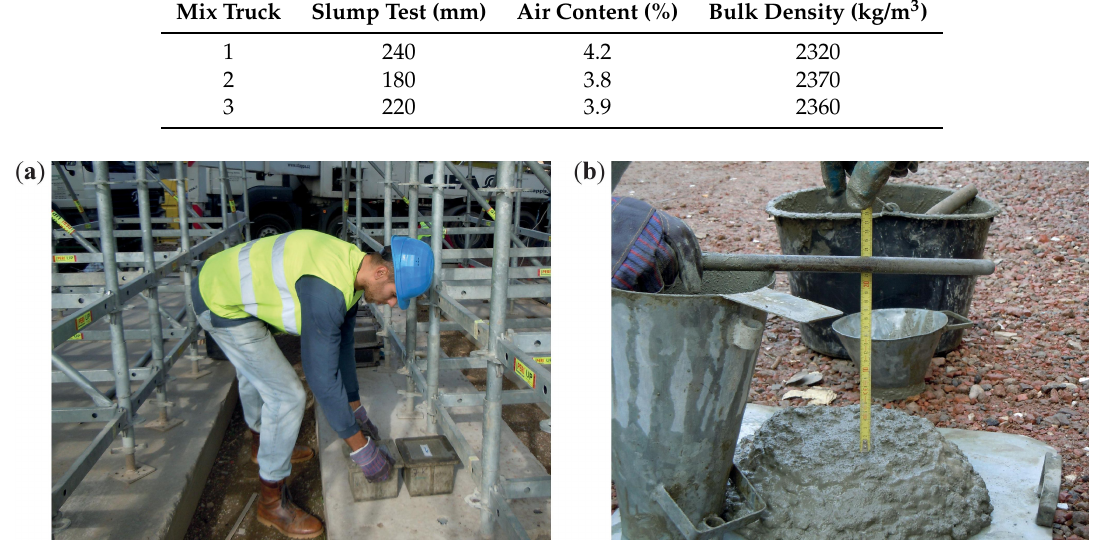
Table 5. Fresh-state properties of concrete C 30/37 XF4.